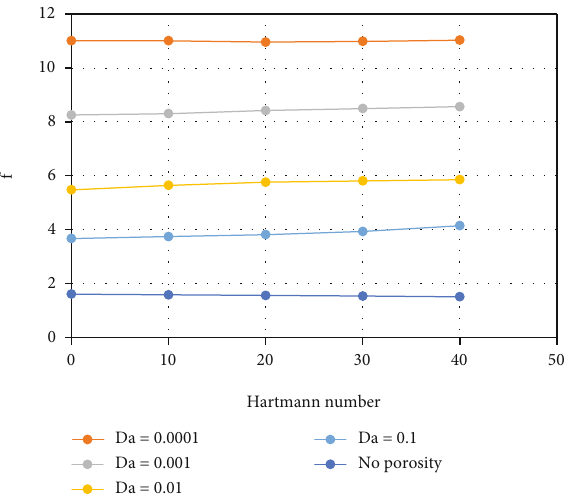
O nano fl uid. 2 3